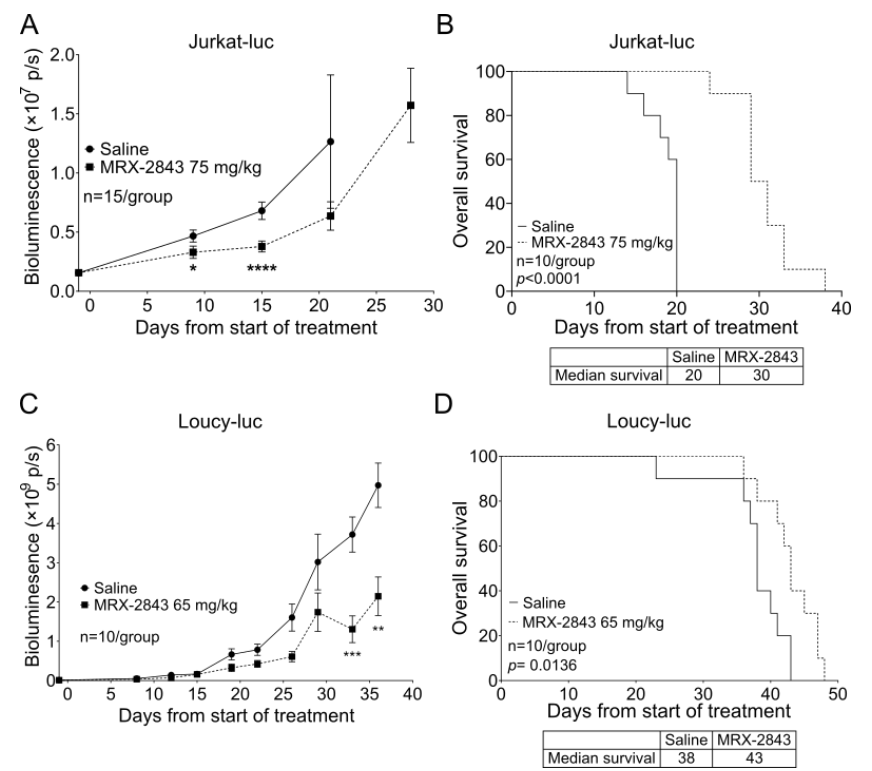
Figure 5. MRX-2843 monotherapy delays disease progression and prolongs survival in orthotopic T-ALL and ETP-ALL xenograft models. ( A – D ) NSG mice were injected with a luciferase-expressing T-ALL cell line cells and once-daily oral treatment with MRX-2843 or saline vehicle was initiated after engraftment of disease. ( A , C ) Disease burden was monitored at intervals by bioluminescence imaging. ( B , D ) Survival was monitored. ( A , B ) Mice inoculated with luciferase-expressing Jurkat cells were treated with 75 mg/kg MRX-2843 or saline for 28 days. ( A ) Mean bioluminescence intensities and SEM are shown (* p < 0.05, **** p < 0.0001, Mann–Whitney-U test, n = 15). ( B ) Survival was significantly prolonged in mice with Jurkat xenografts treated with MRX-2843 ( p < 0.0001, log-rank test, n =10). ( C , D ) Mice inoculated with luciferase-expressing Loucy cells were treated with 65 mg/kg MRX-2843 or saline until removal from the study. ( C ) Mean bioluminescence intensities and SEM are shown (** p ≤ 0.01, *** p ≤ 0.001, Mann–Whitney-U test, n = 10). ( D ) Survival was significantly prolonged in mice with Loucy xenografts treated with MRX-2843 ( p = 0.0136, log-rank test, n =